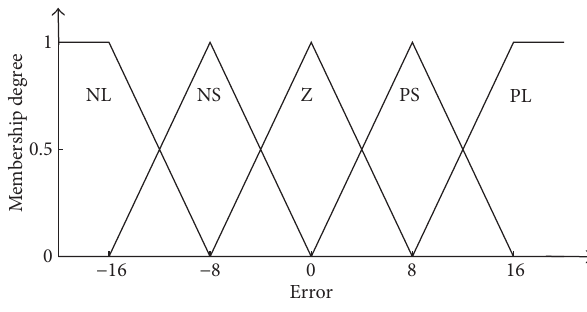
Figure 5: Input membership functions of the FLC.